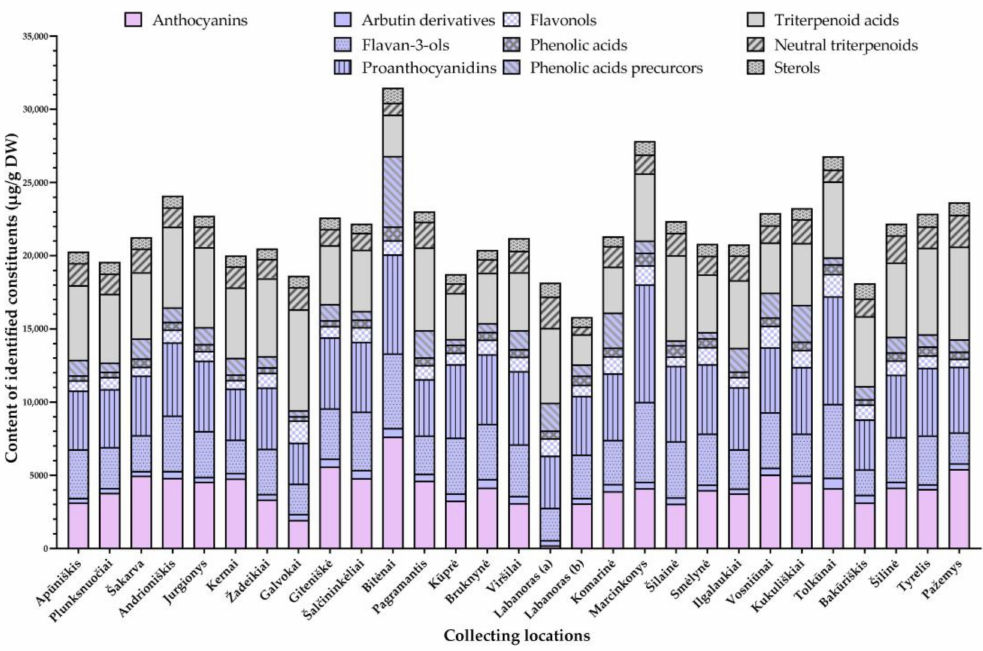
Figure 4. Contents of phenolics, and triterpenoids in lingonberries ( µ g/g DW), collected at different locations.